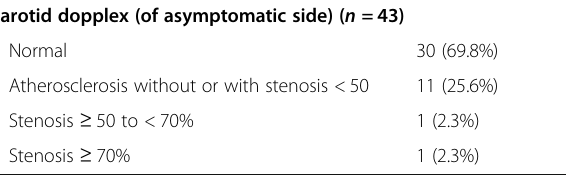
Table 2 Patient assessment and hospital factors pre- and post- thrombolysis in the study sample ( n = 45)